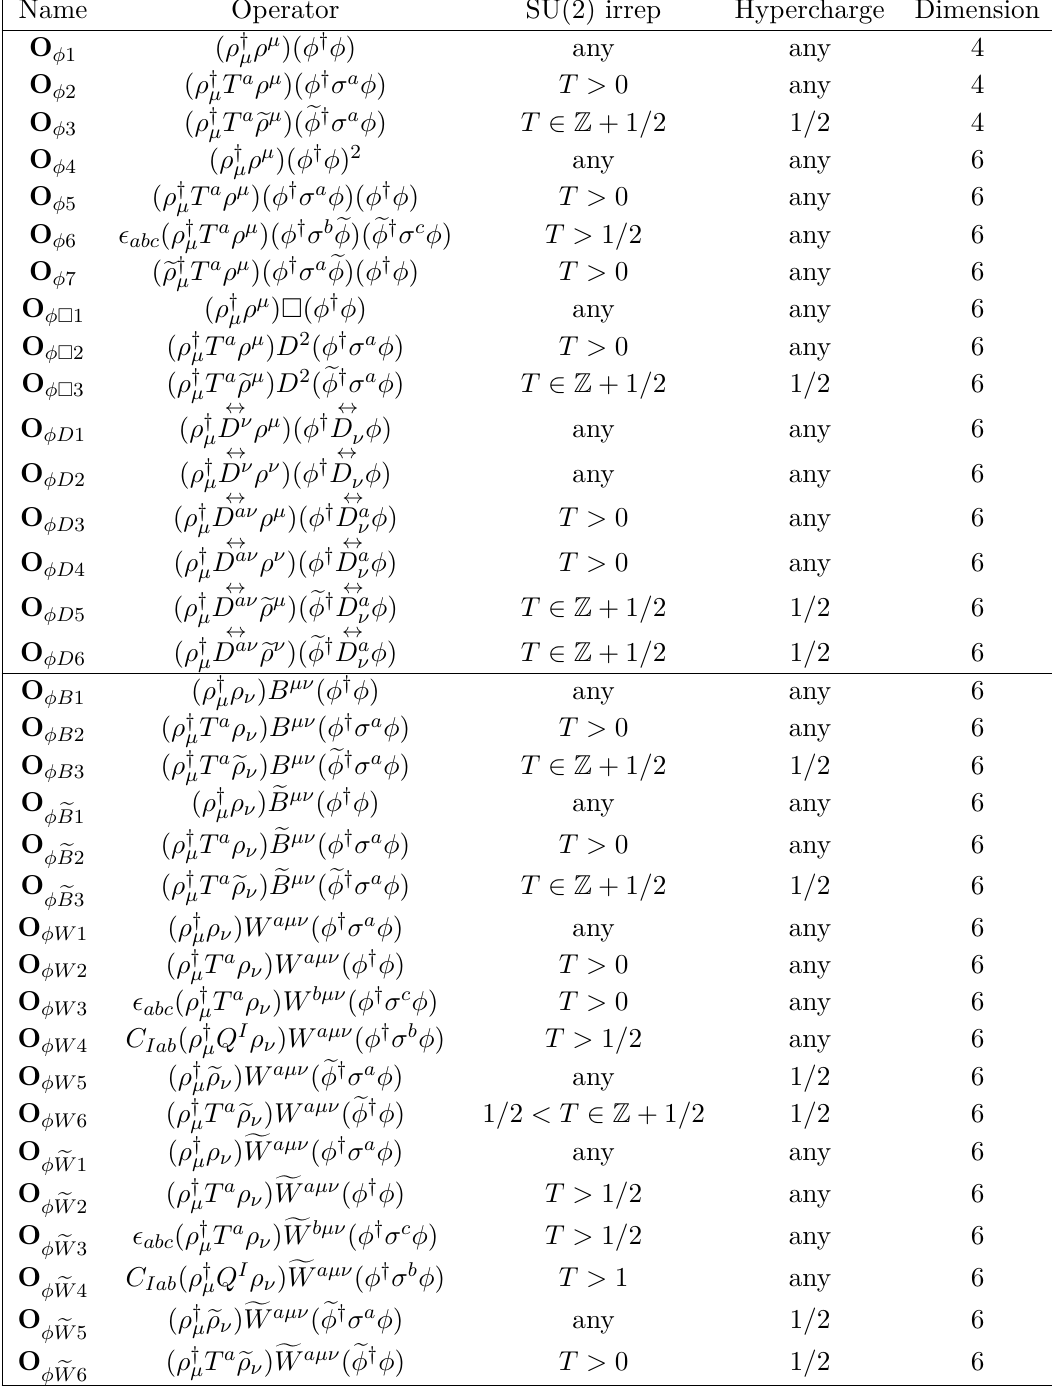
Table 9 . Basis of operators of dimension ≤ 6 with two vector DM multiplets, at least one Higgs boson, and no SM fermions. Q I is the unique set of square matrices acting on the SU(2) part of ρ which transform covariantly as a quadruplet. C Clebsh-Gordan